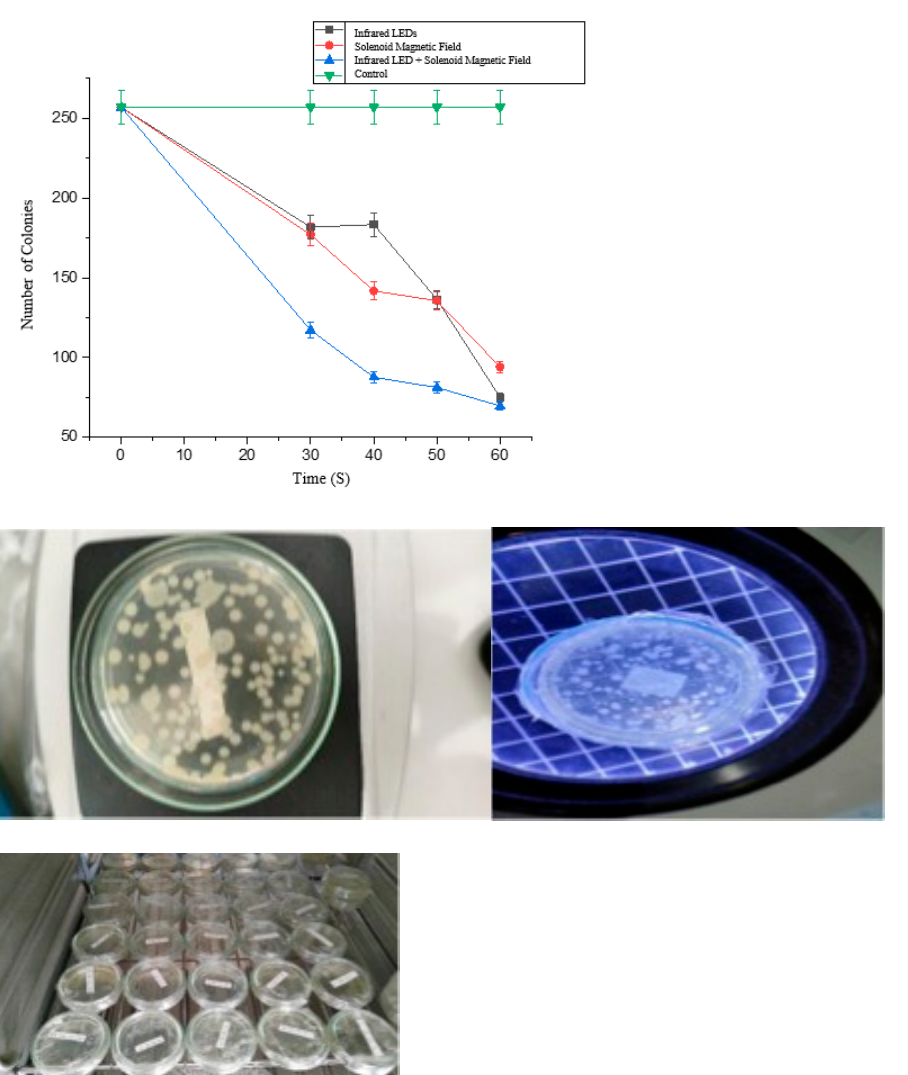
Figure 13. Graph of the decrease in the number of E. coli colonies with time from treatment results with the original agar plate containing the number of colonies .